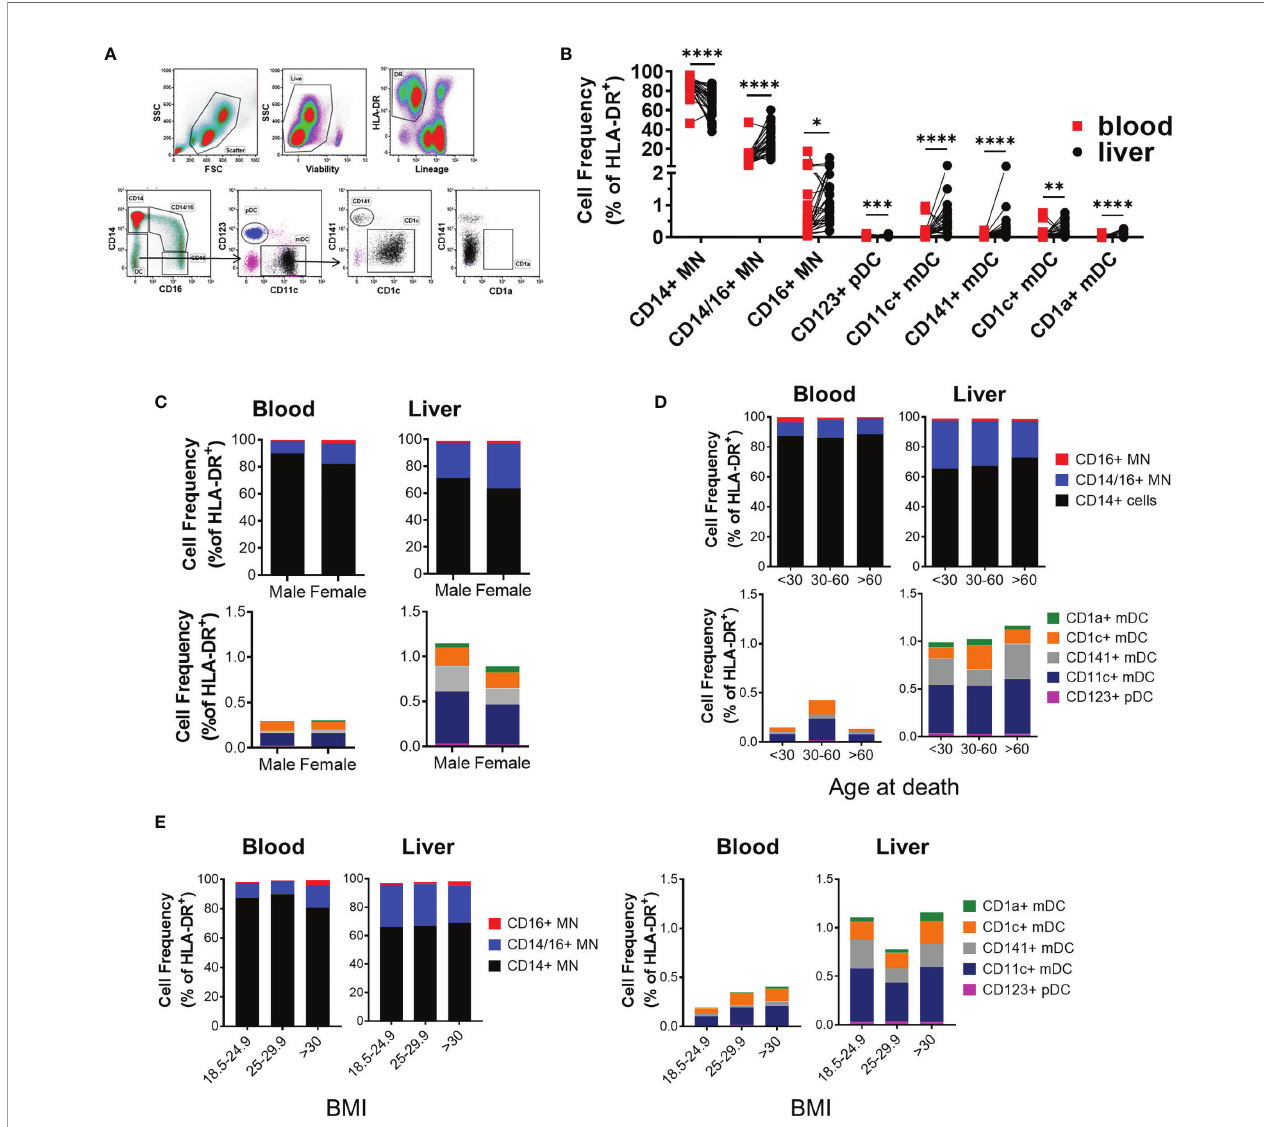
FIGURE 2 | Intrahepatic mononuclear cells from liver perfusions display a pro fi le of organ-speci fi c immune cells. (A) Flow cytometry panel to measure the frequency of IHMC and matched PBMC myeloid frequencies. (B) Summarized myeloid cell frequencies between blood and liver (blood n=27, liver n = 30). Data on frequency displayed as percent of HLA-DR+ cells. Percent of total HLA-DR+ cells for each myeloid population based on (C) Sex (n=18 males, 12 females), (D) Age (<30, n= 8; 30-60, n=15; >60, n=7), or (E) BMI (18.5-24.9 n=13; 25-29.9 n=8; >30 n=9). *p<0.05, **p<0.01, ***p<0.001, ****p<0.0001, Statistical analyses: Mann-Whitney U tests and Kruskal-Wallis tests followed by Dunn ’ s multiple comparisons test when comparing cell frequencies by sex and across age